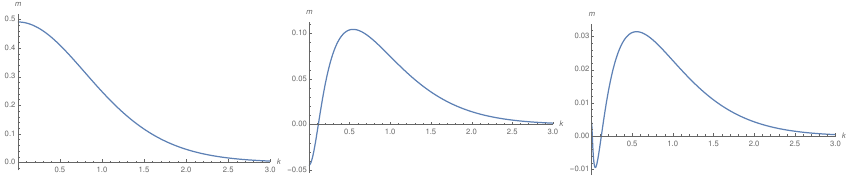
Figure 3. The constituent quark masses m c ( k ) in the chiral limit m 0 = 0, solutions of the mass gap equation, from left to right for the ground state vacuum and first two replicas.